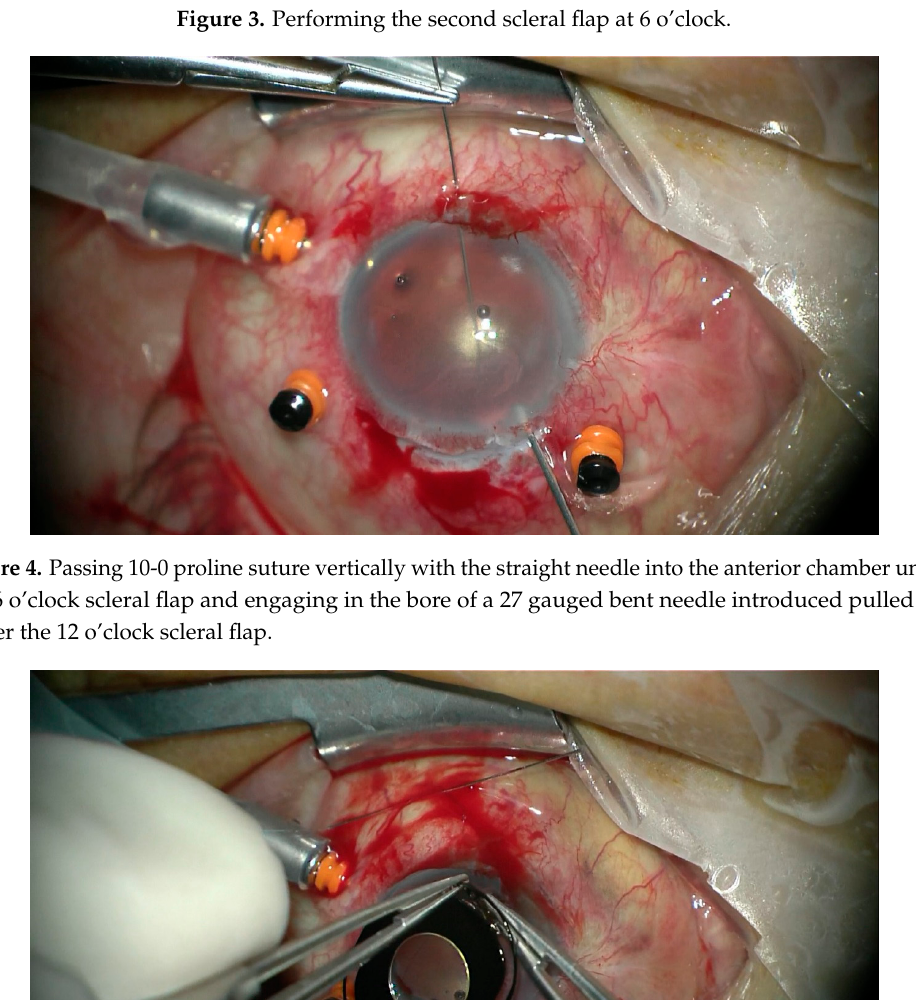
Figure 6. Implanting of black diaphragm intraocular lens while pulling the two sutures from the side.